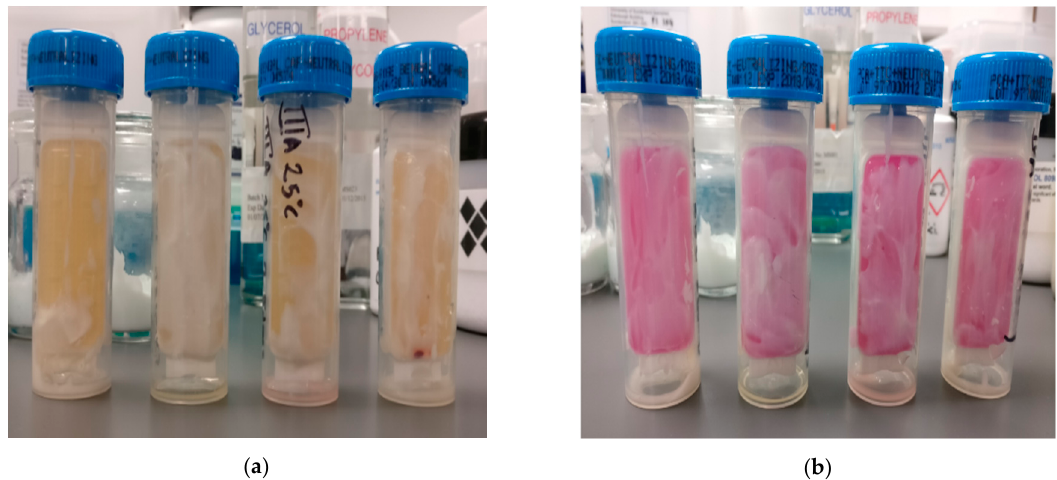
Figure 4. Model IVA under 25 ◦ C storage temperature after 28 days evaluation showing ( a ) TPC of bacteria < 1 CFU / cm 2 ( b ) TCP of yeast or fungi, no colonies formed.